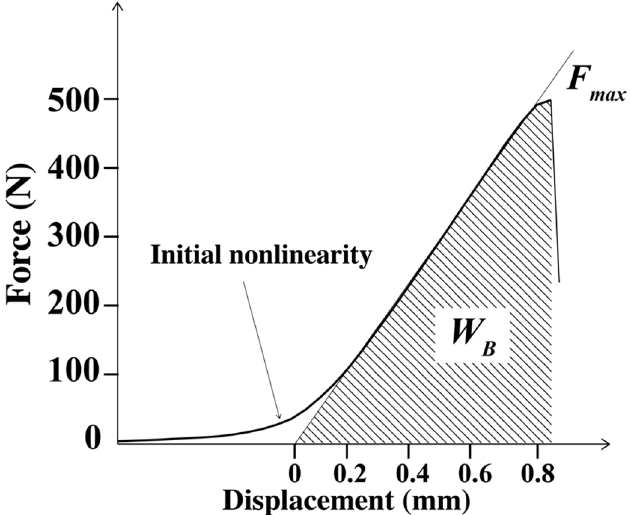
Fig. 12. Typical force – displacement curve obtained with Al/PPS joint specimen and the de fi nition of the energy ( W B ) to be fractured.